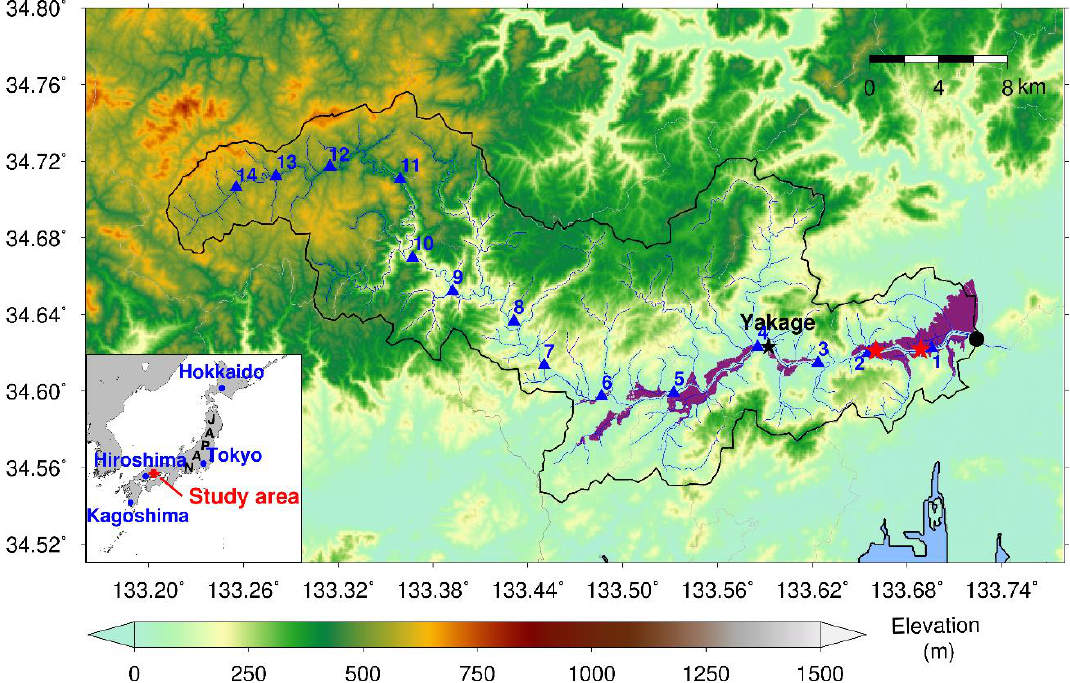
Figure 1. A topographic map showing the location and channel networks of the Oda river basin. Purple shading denotes the estimated flooded area in July 2018 prepared by the Geospatial Information Authority of Japan (GSI). Red stars indicate the failed embankments along the main river channel.